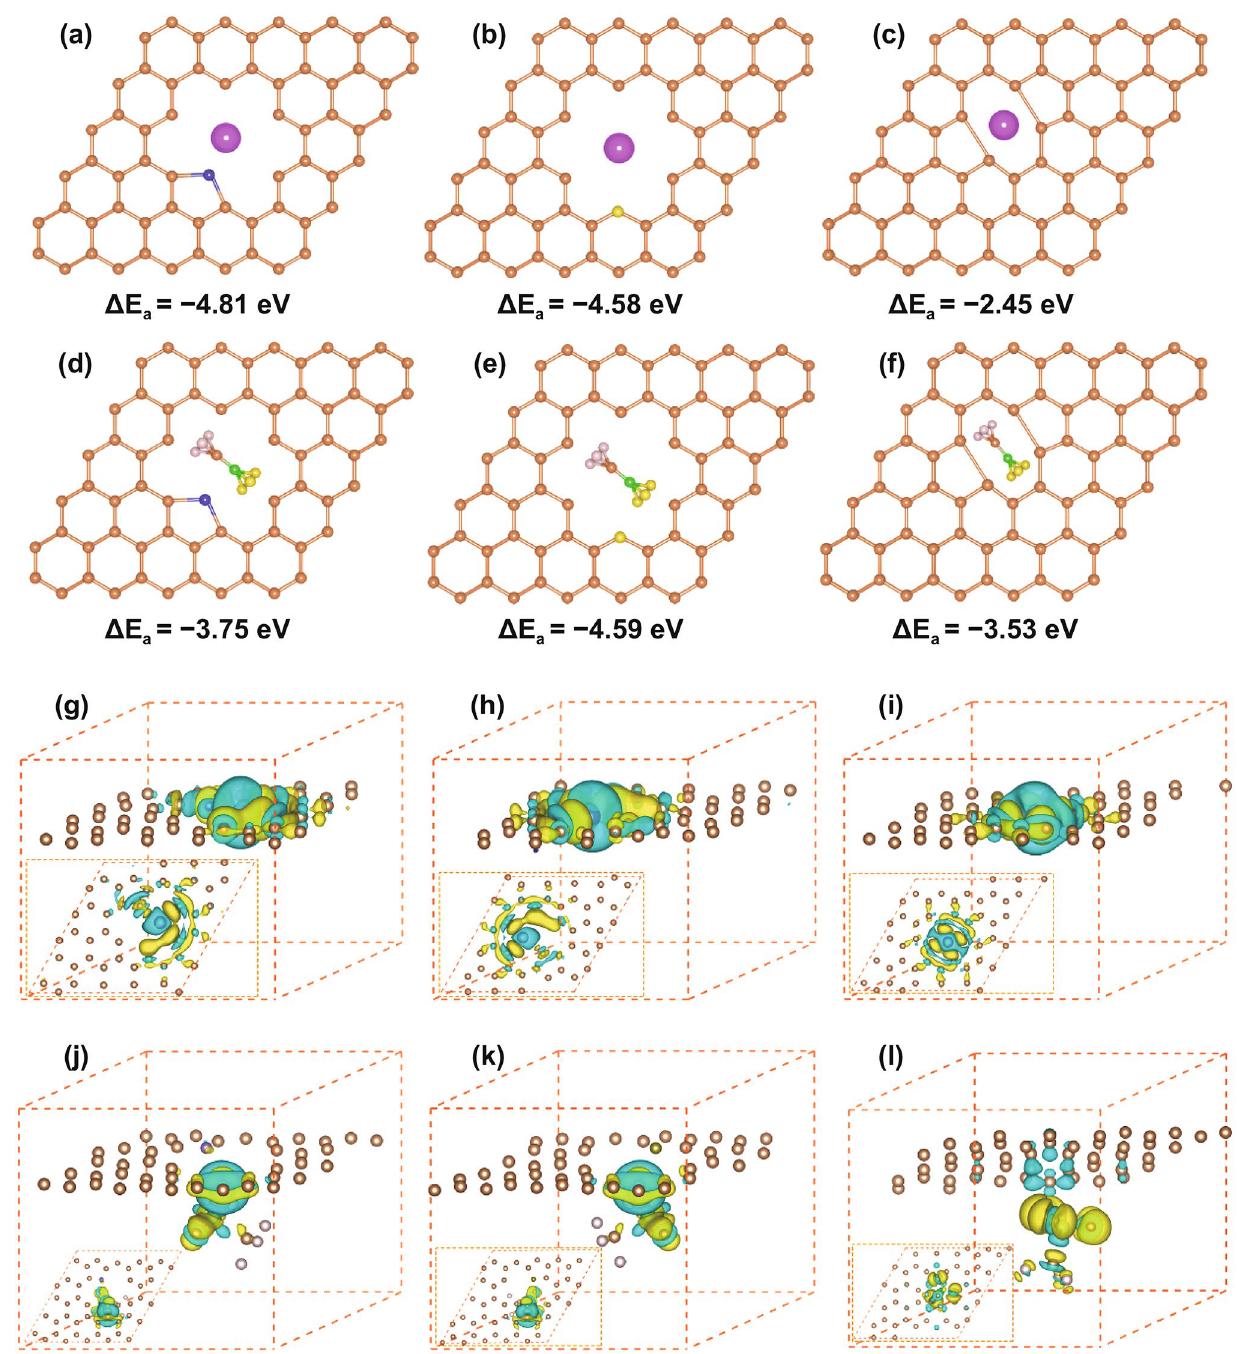
Fig. 4 Theoretical simulations of Zn 2+ /CF 3 SO 3− -adsorption on different graphitic structures. The configurations and corresponding adsorption energy values of single Zn 2+ /CF 3 SO 3− adsorbed at a / d N-5, b / e O-II sites and c / f divacancy sites. Side and top views (inserts) of electron density differences of Zn 2+ /CF 3 SO 3 − absorbed in the g / j N-5, h / k O-II sites and i / l divacancy defect sites. Yellow and blue areas represent the increased and decreased electron density, respectively. Brown, purple, light yellow, green, gray, pink and blue balls represent C, N, O, S, F, Zn, and H atoms, respectively. The iso-surfaces are the 0.002 electron bohr